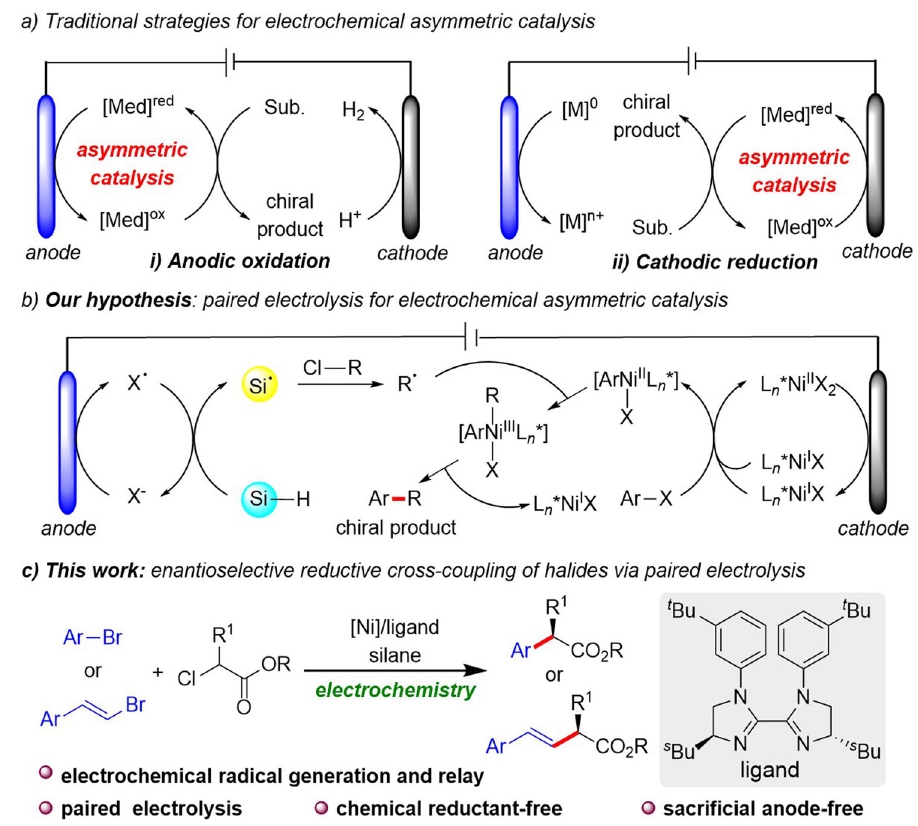
Fig. 1 | Electrochemical asymmetric catalysis. a Traditional strategies for electrochemical asymmetric catalysis. b Paired electrolysis for electrochemical asymmetric catalysis. c This